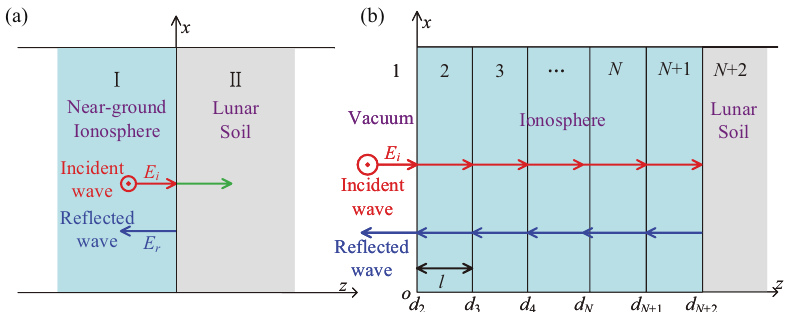
Figure 2. Schematic of lunar surface soil reflection and waves propagation in the lunar ionosphere. ( a ) the local enlarged schematic diagram of the N + 1 and N + 2 layers in ( b ), ( b ) the schematic diagram of electromagnetic wave propagation in the stratified dusty